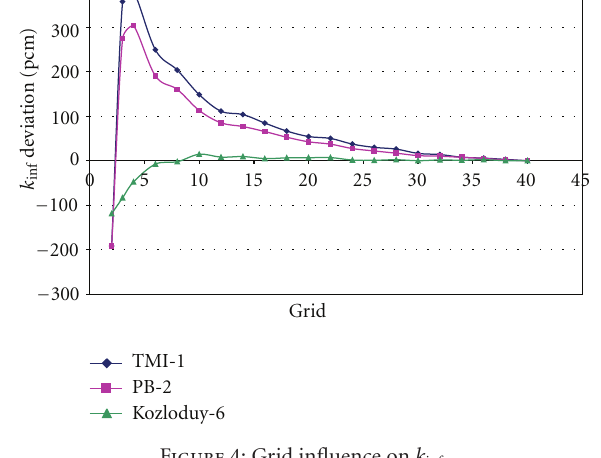
Figure 4: Grid influence on k inf .